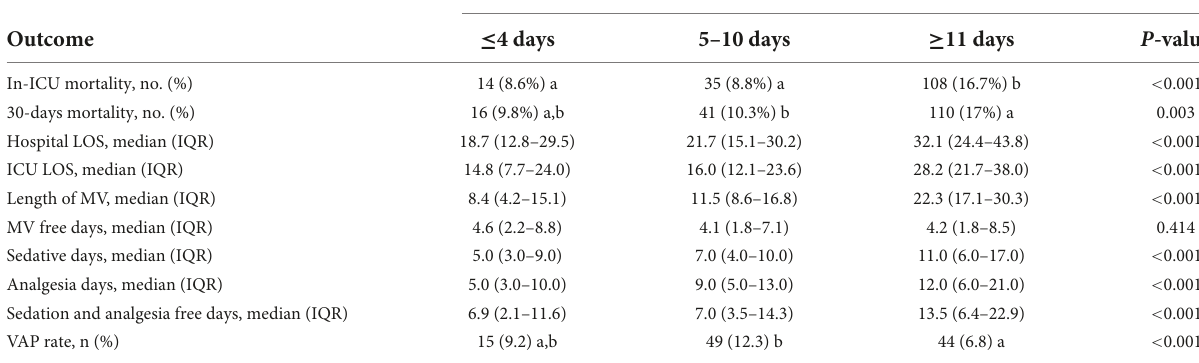
TABLE 4 Secondary